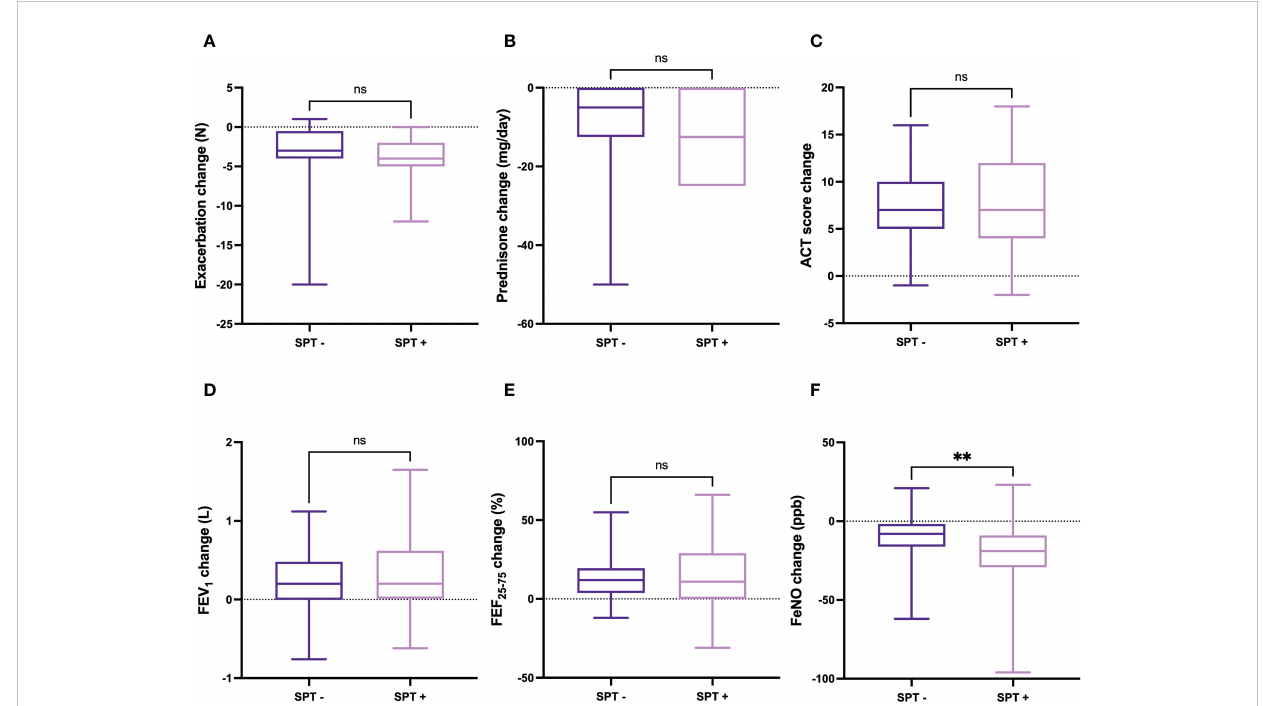
FIGURE 2 Comparative evaluation of dupilumab effects in relation to SPT negativity or positivity, with regard to asthma exacerbations (A) , prednisone intake (B) , ACT score (C) , FEV1 (D) , FEF25-75 (E) , and FeNO levels (F) . Boxes display median values and IQR, and whiskers de fi ne maximum and minimum. ns, not signi fi cant; ** p <